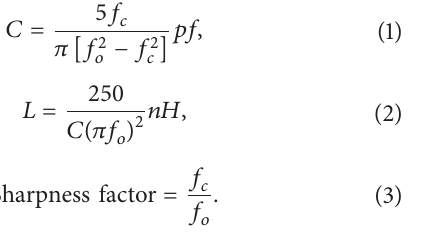
Figure 2: Comparison of simulated S-parameter of all DB-DGS